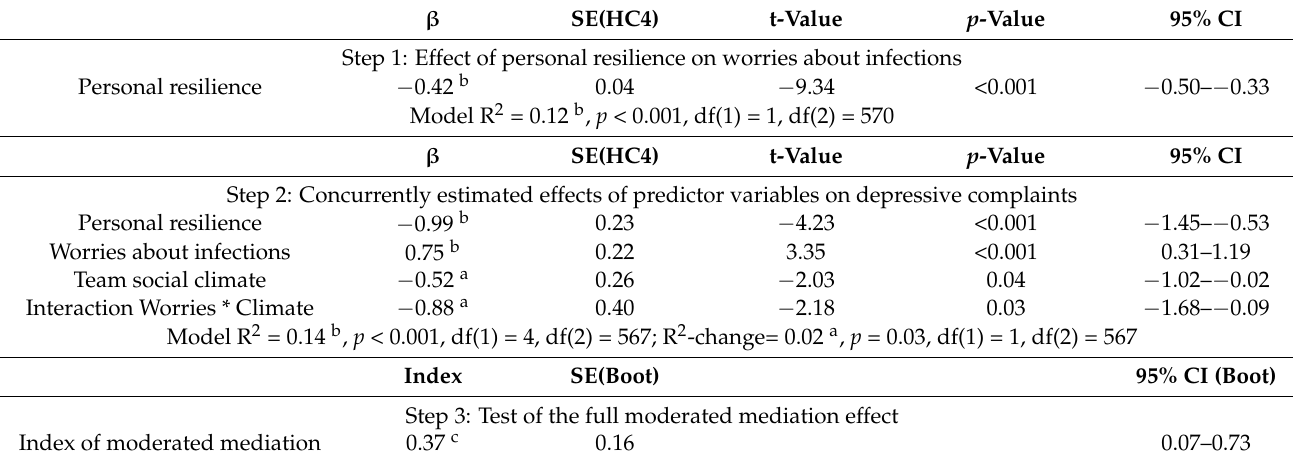
Table 2. Stepwise estimated effects from the moderated mediation